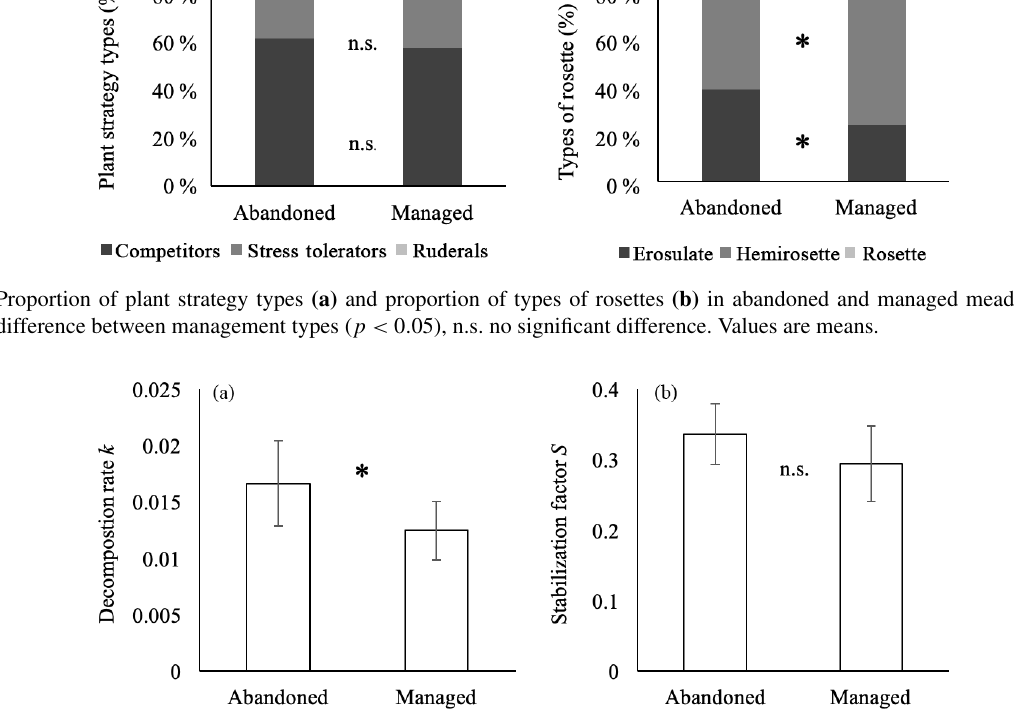
Figure 5. Decomposition rate k (a) and stabilization factor S (b) measured with tea bag index in abandoned and managed meadows. ∗ denotes significant difference between management types ( p < 0 . 05), n.s. no significant difference. Values are means ±